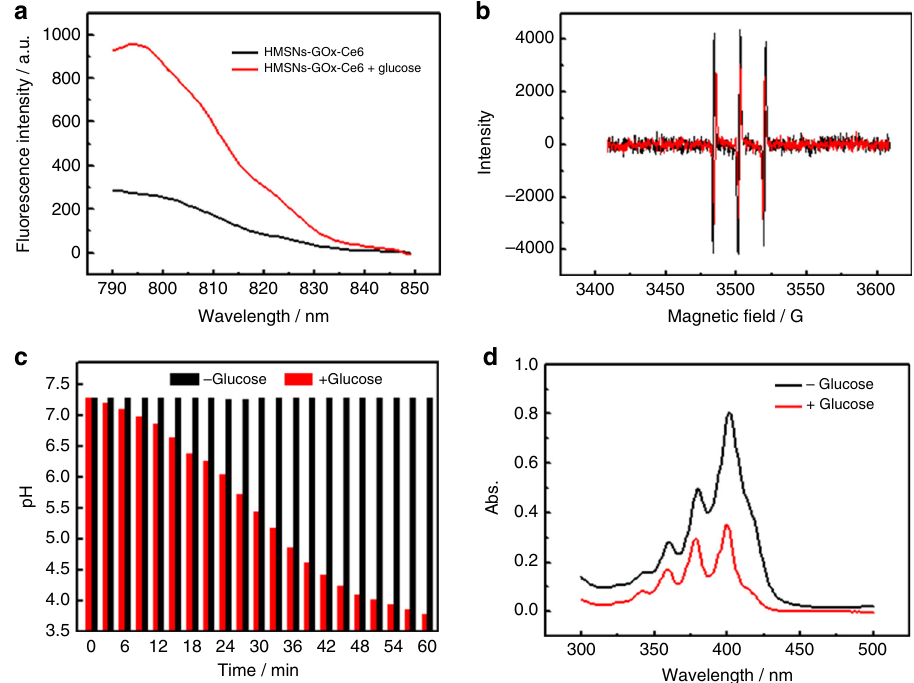
Fig. 3 Veri fi cation of H 2 O 2 and 1 O 2 generation in vitro. a Fluorescence spectra of Cy-O-Eb probe incubated with HMSNs-GOx-Ce6 in the presence or absence of 1 mM glucose. b ESR spectra of TEMPO after incubation with HMSNs-GOx-Ce6 and Fe 2 + in the presence (red) or absence (black) of glucose. c The pH values of HMSNs-GOx-Ce6 solution in the presence or absence of 1 mM glucose. d Absorption spectra of ABMD incubated with HMSNs-GOx- Ce6@CPPO-PFC/O 2 in the absence or presence of 1 mM